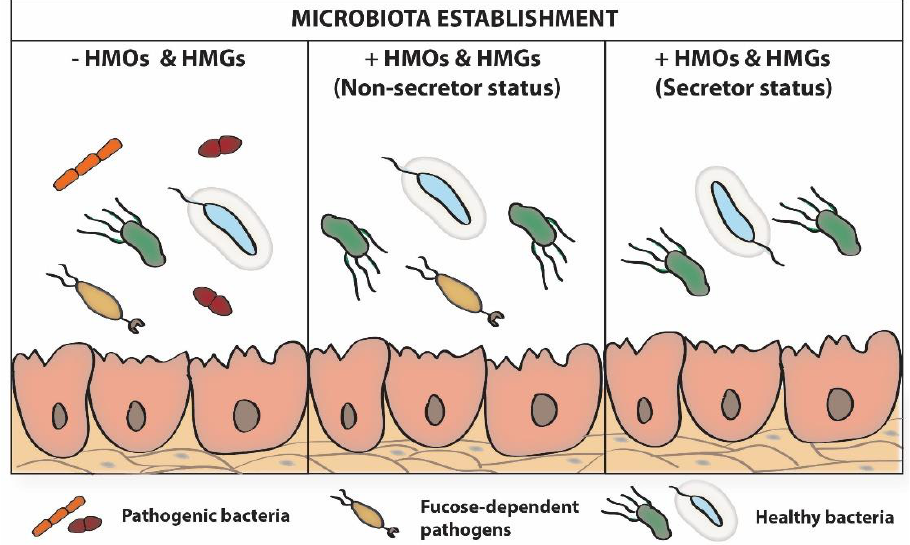
Figure 3. The impact of maternal secretor status on infant’s microbiota establishment [96,97]. HMOs, human milk oligosaccharides; HMGs, human milk glycoproteins.